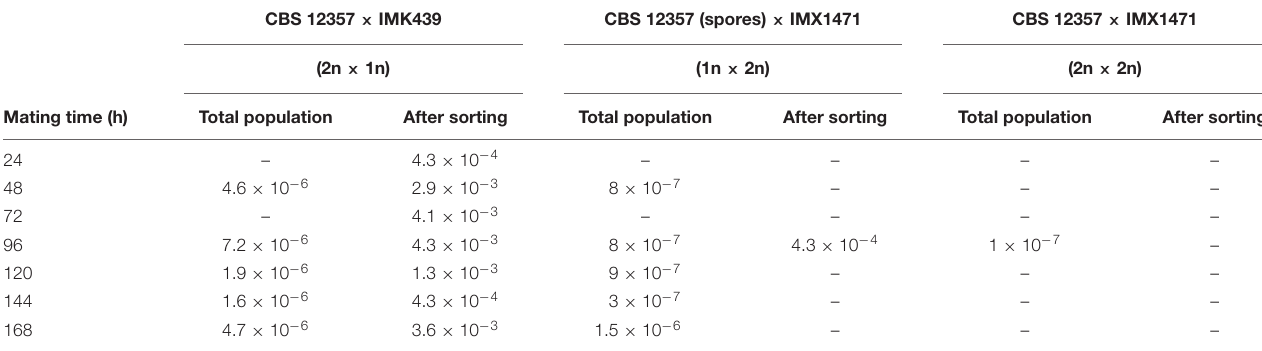
TABLE 2 | Fraction of hybrid cells after interspecies rare mating between S. eubayanus strain CBS 12357 and S. cerevisiae strains IMK439 (1n) and IMX1471 (2n) as determined by the ability to grow on SM +